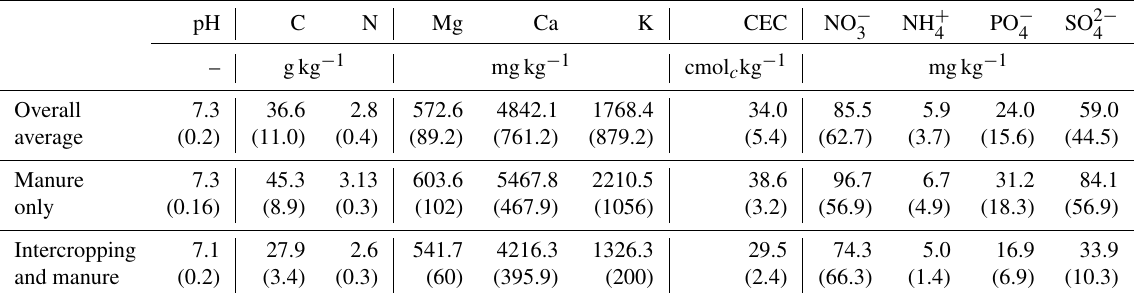
Table 3. Average pH; total C and N (gkg − 1 ); exchangeable Mg, Ca, K, and Na (mgkg − 1 ); CEC (cmol c kg − 1 ); and water-soluble